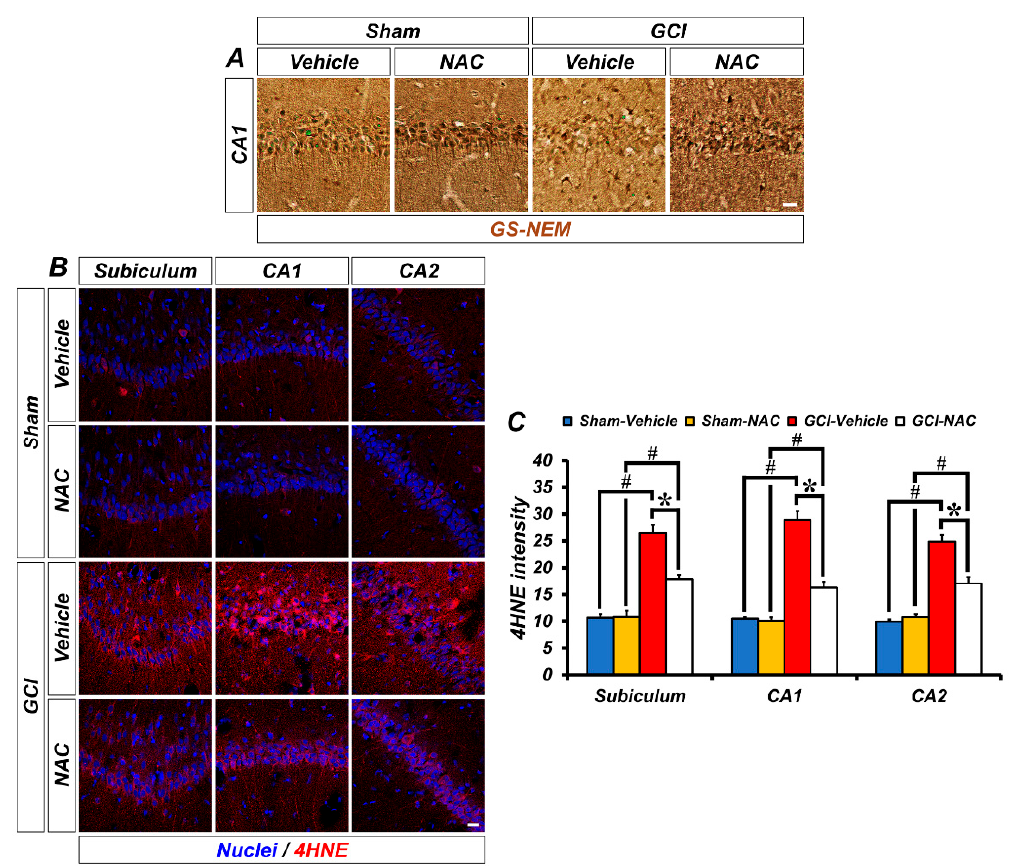
Figure 3. GCI-induced decreasing concentration of glutathione and increasing oxidative damage was restored by anti-oxidant, NAC. ( A ) Representative histological images show concentration of glutathione marker GS-NEM in the hippocampal CA1. Neuronal glutathione level was remarkably reduced after GCI and was restored to normal levels. Scale bar = 20 µ m. ( B ) 4-hydroxy-2-nonenal (4-HNE) immunofluorescence staining was used as a marker for lipid peroxidation. Sham–vehicle and NAC groups show minimized 4-HNE-positive signal (red color) in hippocampal regions. It was remarkably increased in the GCI–vehicle group and NAC administration after GCI attenuates oxidative damage-induced lipid peroxidation. Scale bar = 20 µ m. ( C ) Bar graph means intensity of 4-HNE signal in the hippocampal regions. Data are mean ± SEM, n = 4–7 each group, * p < 0.05 versus vehicle-treated group; # p < 0.05 versus sham-operated group (Kruskal–Wallis test followed by Bonferroni post-hoc test, Subiculum: chi square = 18.688, df = 3, p < 0.001; CA1: chi square = 18.783, df = 3, p < 0.001; CA2: chi square = 18.229, df = 3, p < 0.001).